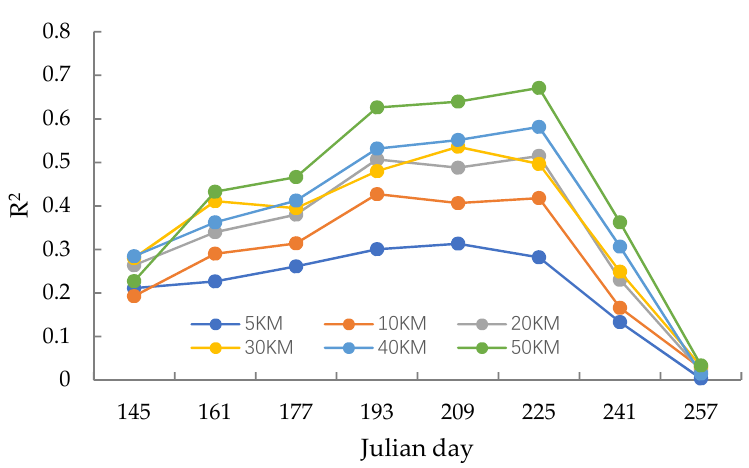
Figure 6. Coefficient of determination (R 2 ) obtained from a linear regression model between SIF and EVI computed every 16 days and considering different spatial scales.